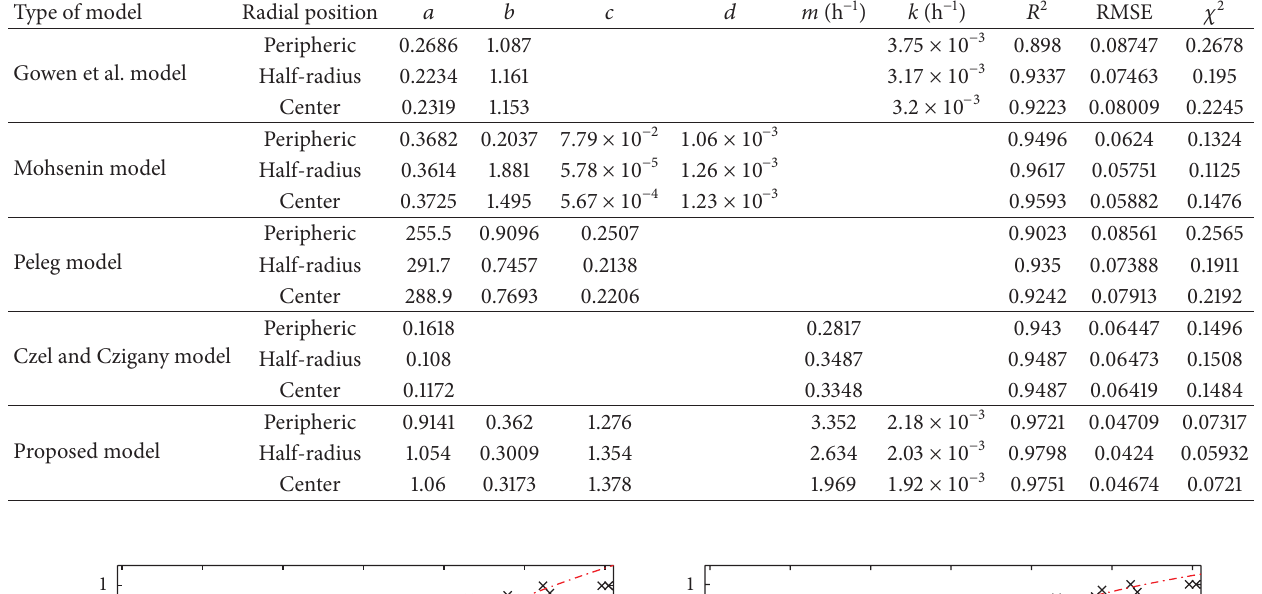
Table 3: Values of the parameters of the different models of fibres located at base (PL-1/4) of the stem of raffia. Type of model